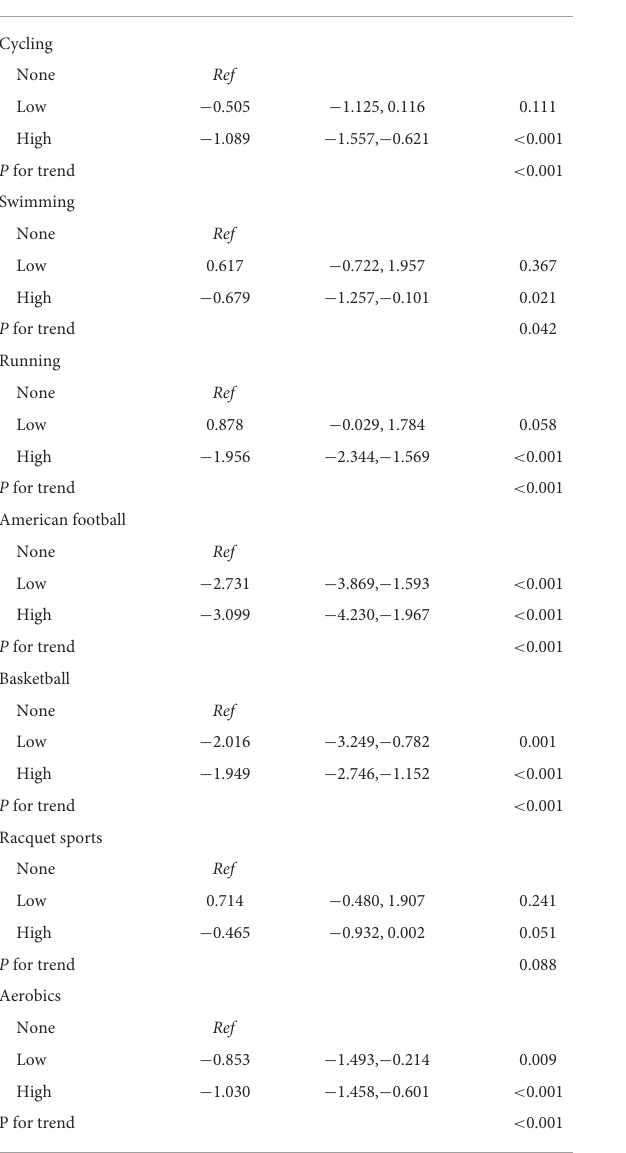
TABLE 5 Associations of the volume of specific types of physical activities with CVD risk in adults aged ≥ 30 years * .